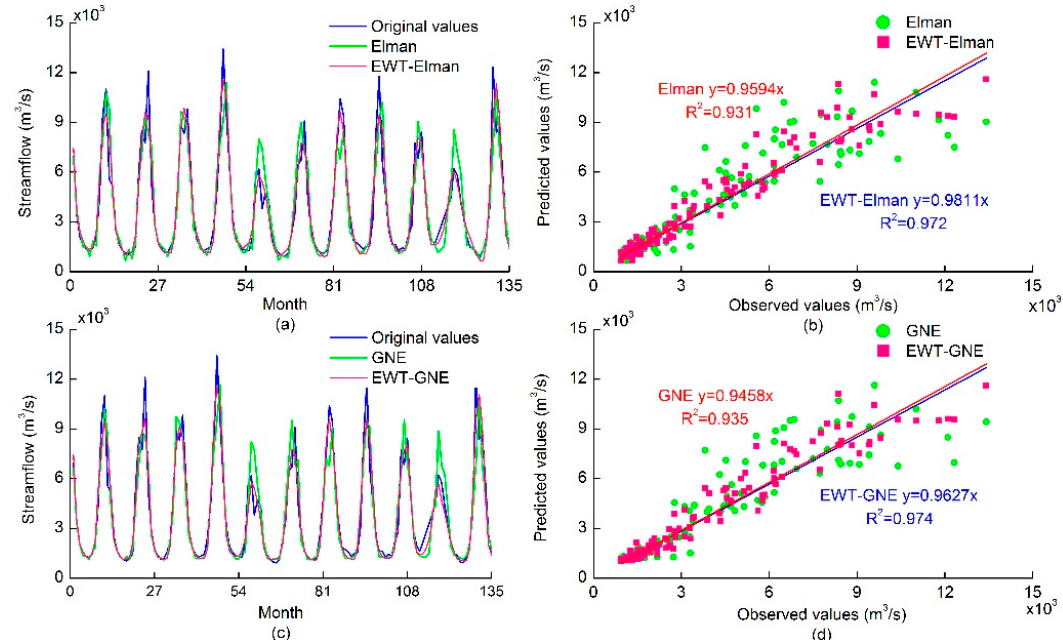
Figure 6. Forecasting results of the Elman (GNE) and EWT-Elman (EWT-GNE) models in the validation stage.